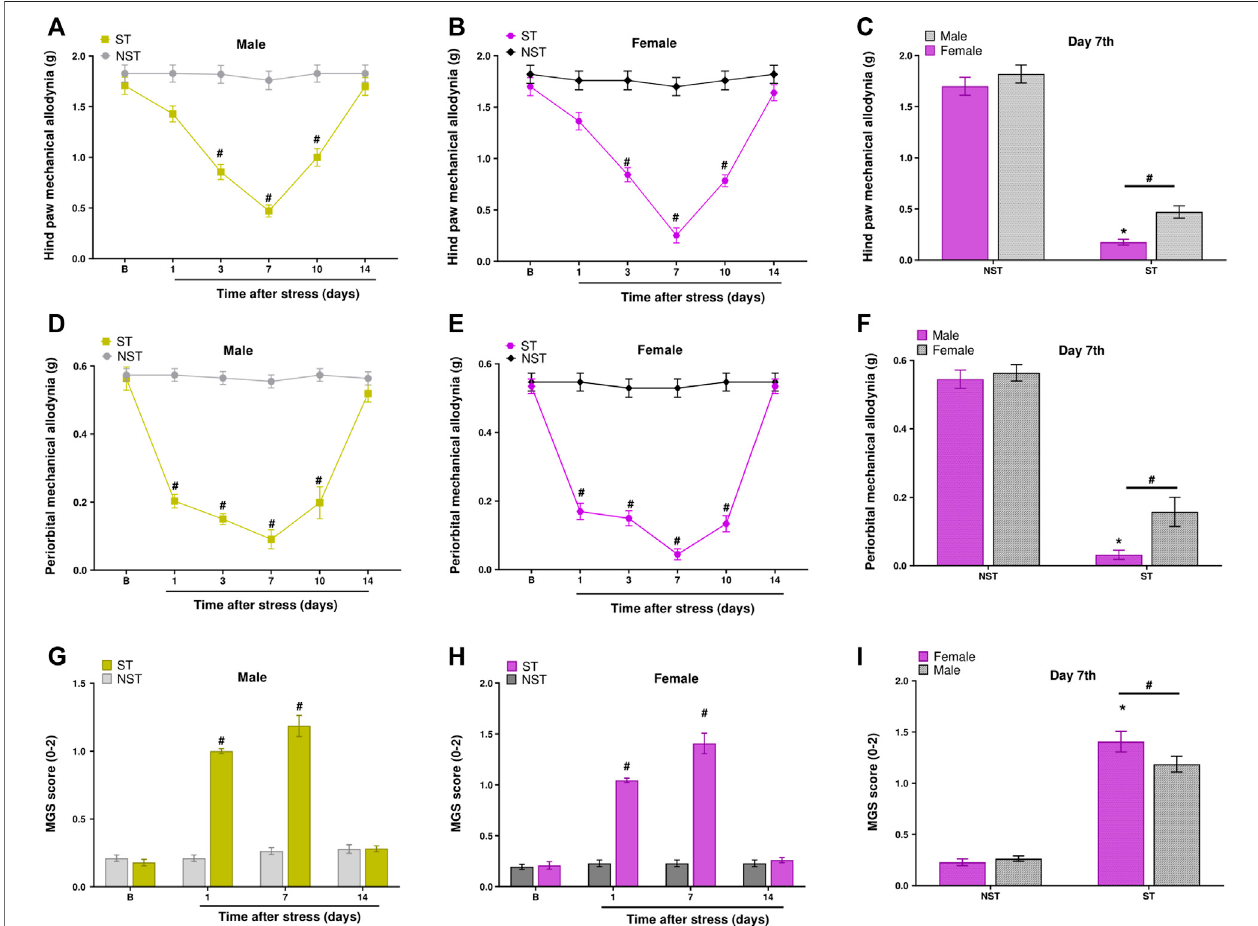
FIGURE 2 | Unpredictable sound stress evokes periorbital mechanical allodynia (PMA), hind paw mechanical allodynia, and grimacing pain behavior in mice. Hind paw mechanical allodynia was measured in (A) male and (B) female mice at different time points after stress (ST group) or control (non-stressed group, NST). (C) Comparisonofhindpawmechanicalallodyniabetweenmaleandfemalemiceatday7afterstressorinNSTgroup.PMAwasmeasured in (D) maleand (E) femalemice. (F) ComparisonofPMAbetweenmaleandfemalemiceatday7afterstressorintheNSTgroup.Grimacingpainbehaviorwasevaluatedin (G) maleand (H) female atdifferenttimepointsafterstress(STgroup)orcontrol(non-stressedgroup,NST). (I) Comparisonofgrimacingpainbehaviormaleandfemalemiceatday7afterstress orinNSTgroup.Baselinemeasurements(describedasBinthegraph)weretakenbeforeinduction.Spontaneousnociceptionwasanalyzedbythemousegrimacescale (MGS).Dataareexpressedasmean±S.E.M.( n =8). # p < 0.05whencomparedtotheNSTgroup,andbetweendays(1,7,and14post-stress)comparingtheSTgroup and NST group. * p < 0.05, when compared between the sexes within the ST group [repeated measures two-way ANOVA followed by Bonferroni ’ s post hoc test].